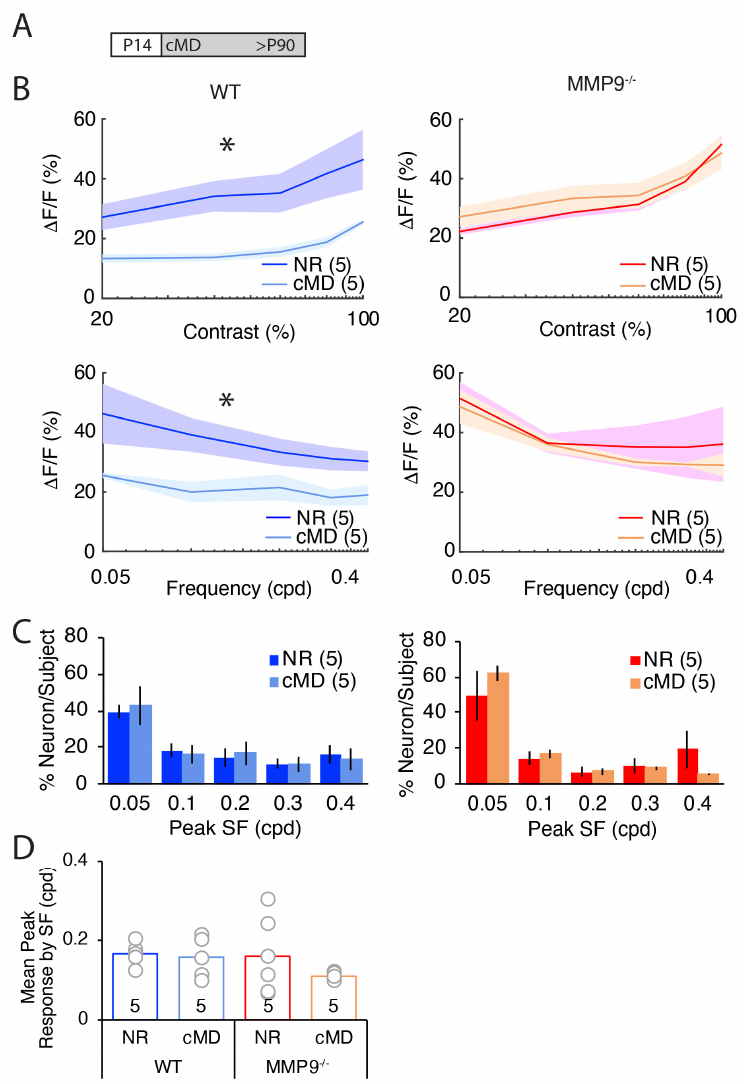
Figure 5. cMD impairs the strength of visual responses across contrasts and spatial frequencies in WT, but not MMP9 − / − mice. ( A ) Experimental paradigm. ( B ) Significant decrease in the strength of neuronal responses to a range of contrasts (top) and spatial frequencies (bottom) in cMD versus NR WT (left), but not in MMP9 − / − (right) mice. Mean ∆ F/F values of responsive neurons are plotted for NR (dark blue) and cMD (light blue) for WT, NR (red) and cMD (orange) for MMP9 − / − (repeated measures ANOVAs: contrast at 0.05 cpd, WT F = 9.7, * p = 0.014, MMP9 − / − F = 0.20, p = 0.67; spatial frequency at 100% contrast: WT F = 8.3, * p = 0.020, MMP9 − / − F = 0.33, p = 0.58; n = 5 subjects). ( C ) Distribution of the spatial frequency evoking the peak neuronal response. Right: NR WT (dark blue) and cMD WT (light blue). Left: NR MMP9 − / − (red) and cMD MMP9 − / − (orange). Mean ± SEM, n = 5 subjects. ( D ) Mean peak spatial frequency is similar in cMD and NR in both WT and MMP9 − / − mice (one-way ANOVA, F = 0.89, p = 0.47, n = 5